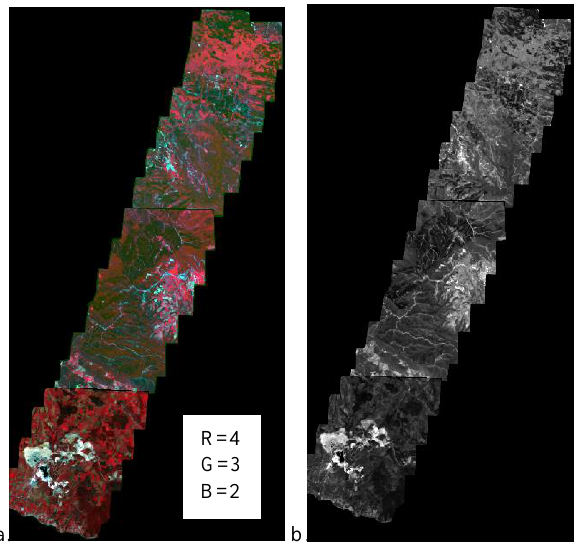
Figure 11. a: Geoeye-1 orthoMS (2m), b: Geoeye-1 orthoPAN (0.5m).